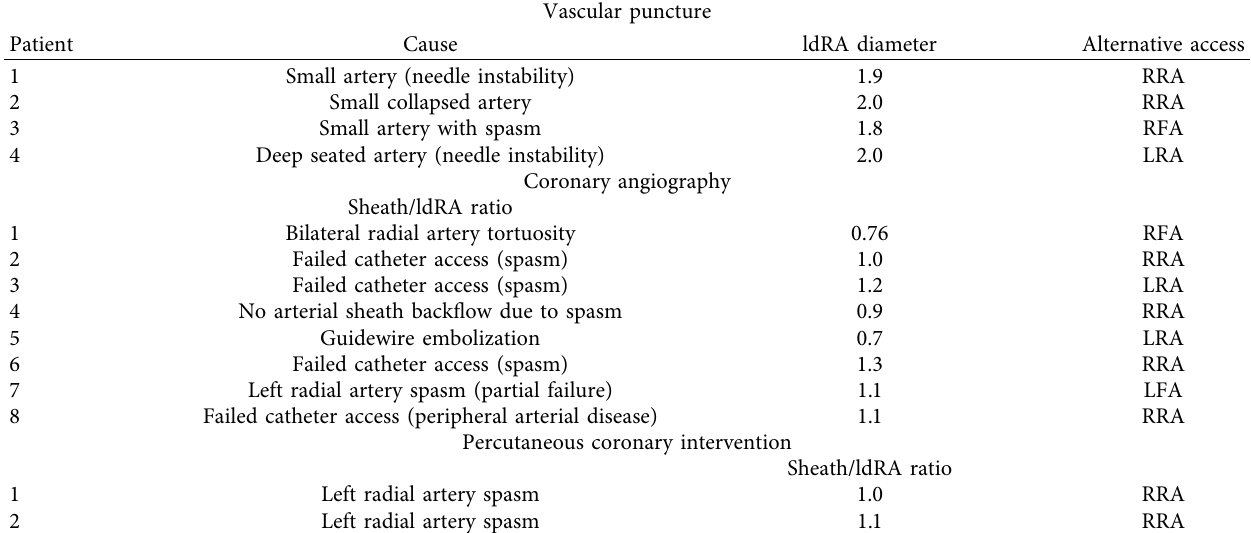
Table 3: Procedure failures during the study.